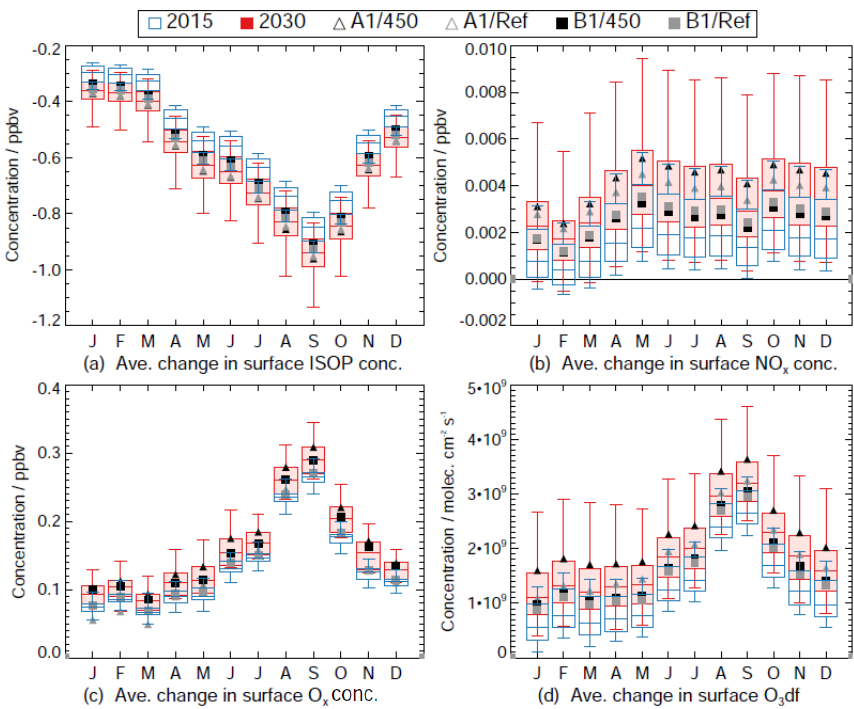
Fig. 9. Same as Fig. 7 but for tropical South America (Fig. 6).